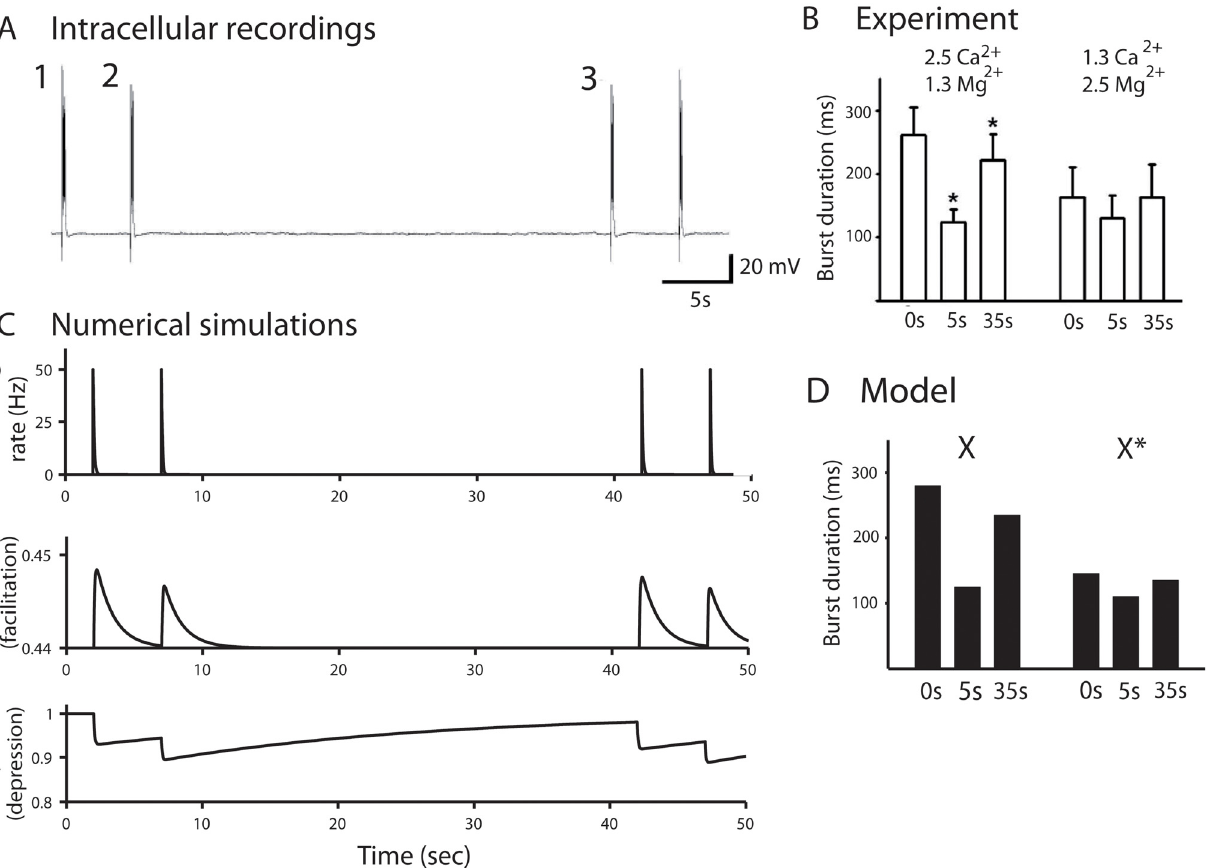
Fig 7. The bursting duration in slices depends on synaptic AMPA receptors. (A) CNQX (1 μ M) eliminated the bursting reverberation. (B) Bursting duration at 0, 5, and 35 s before and after CNQX application. ( * P < 0.05, compared with 0 s, Student ’ s paired t-test). Ratio of bursting duration at 5 s before and after CNQX application ( * P < 0.05, compared with control, Student ’ s paired t-test, n = 4). (C) Injection of 100 pA positive current into the patched pyramidal neuron triggered bursting without depression in 5 and 35 s interval, confirming that the bursting duration is synaptically